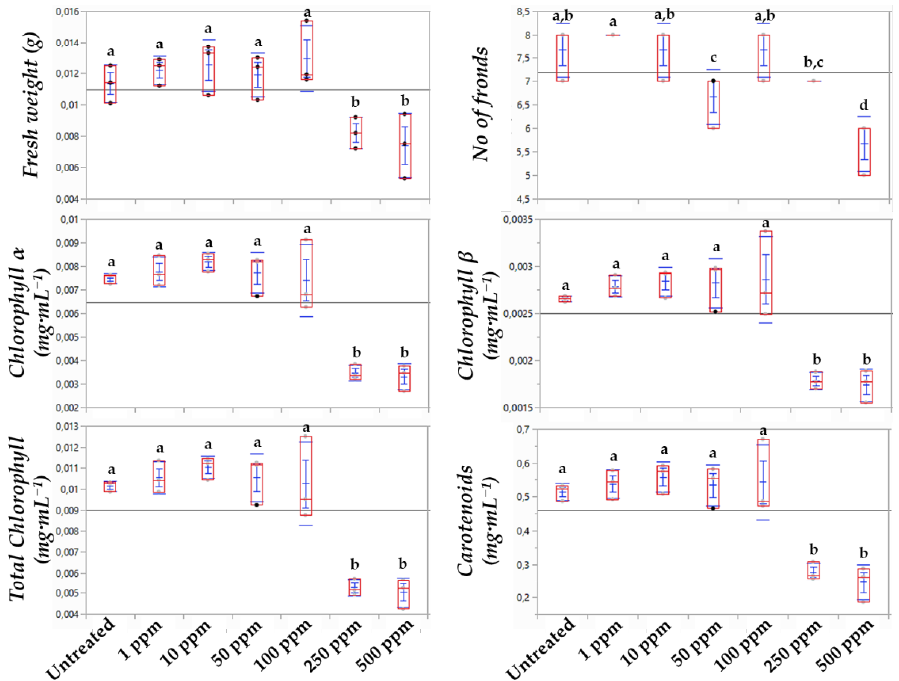
Figure 2. Box plots demonstrating the effect of the Bacillus sp. PTA13 lipopeptide extract on the fresh weight, number of fronds, and chlorophyll ( α , β and total) and carotenoid contents of Lemna minor L. 72 h following treatment. The extract was applied at 1, 10, 50, 100, 250, and 500 μg ‧ mL – 1 and